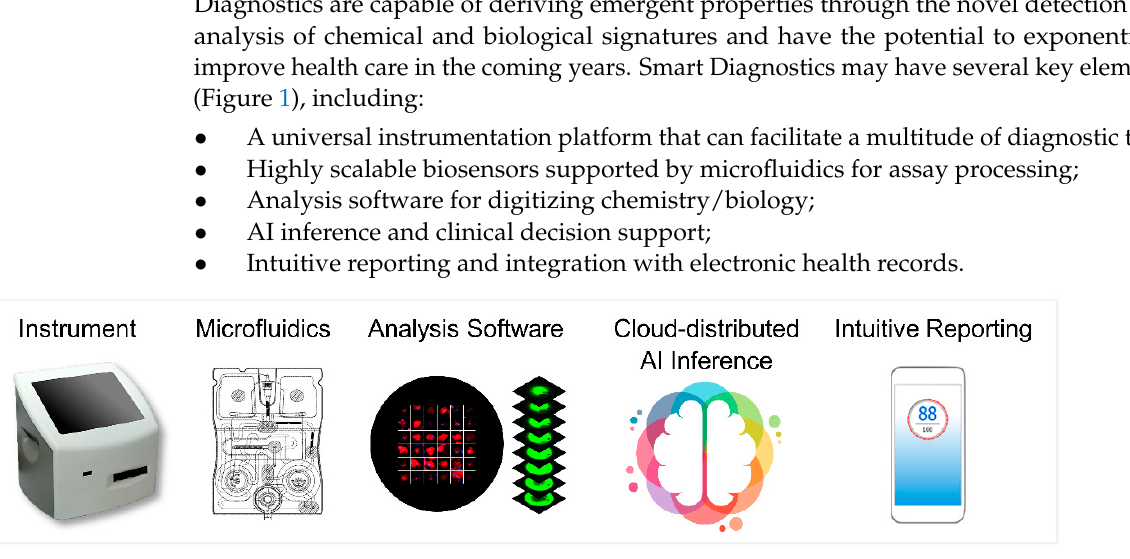
Figure 1. Elements of a Smart Diagnostics platform.